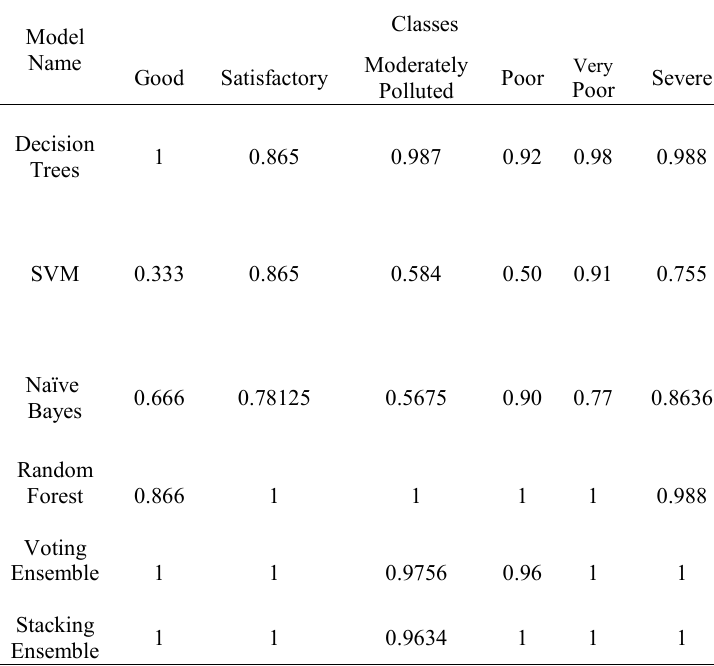
Table 3. Precision Values for Various Classification and Ensemble